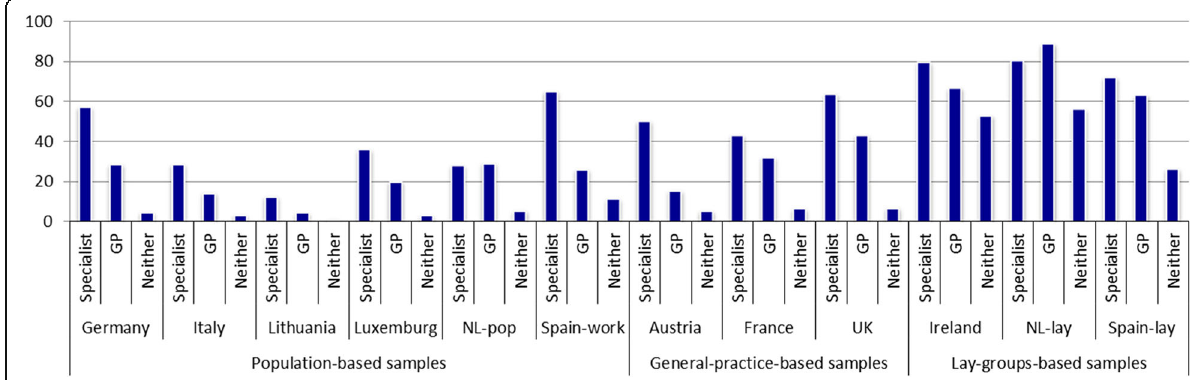
Fig. 1 Proportion (%) of participants with migraine using triptans, by country and by whom consulting. NL-pop: Netherlands-population; Spain-work: Spain-workplace; NL-lay: